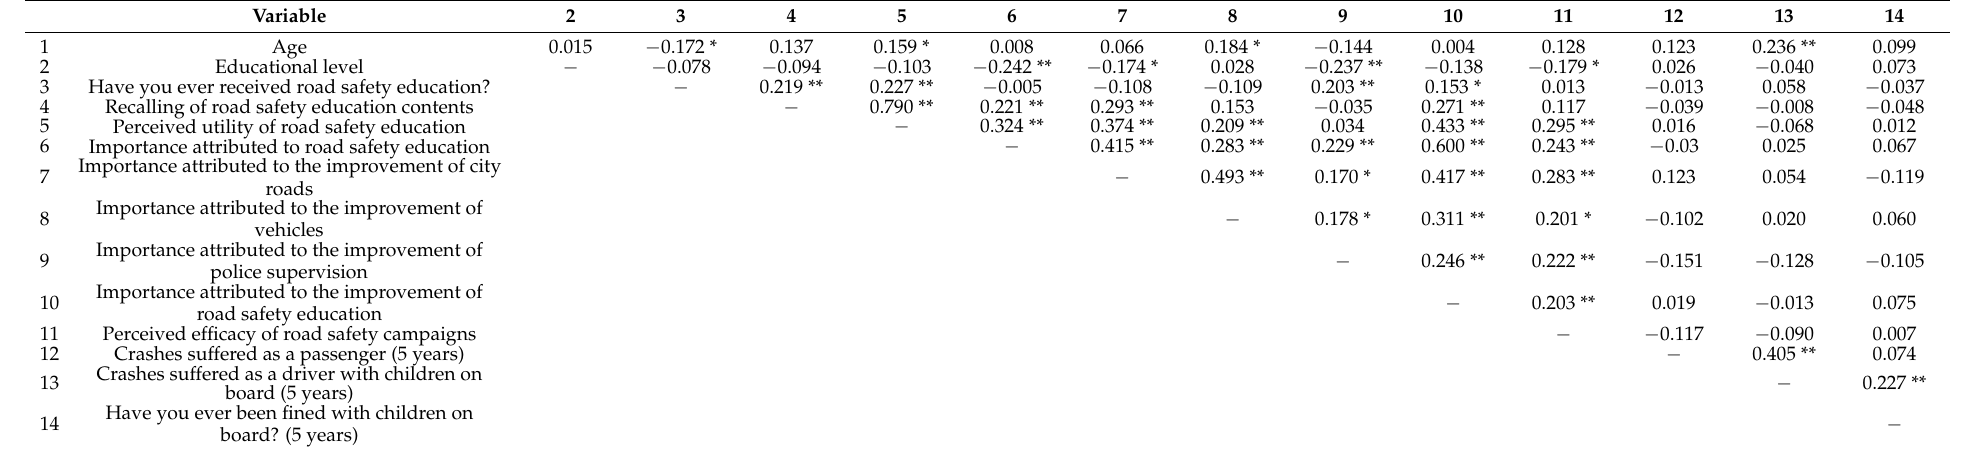
Table 1. Bivariate (Spearman) correlations between study